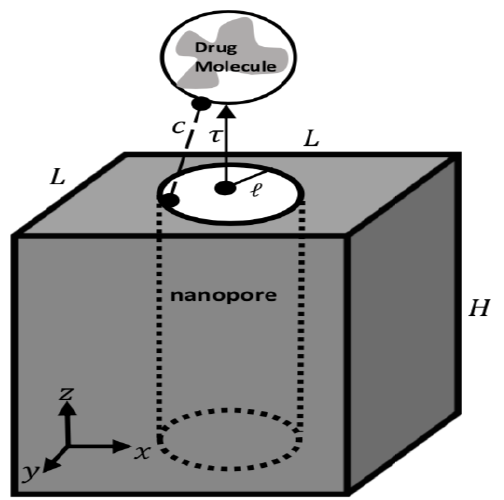
Figure 1. Optimized geometry of the adsorption of the drug molecule onto SiO 2 and Au